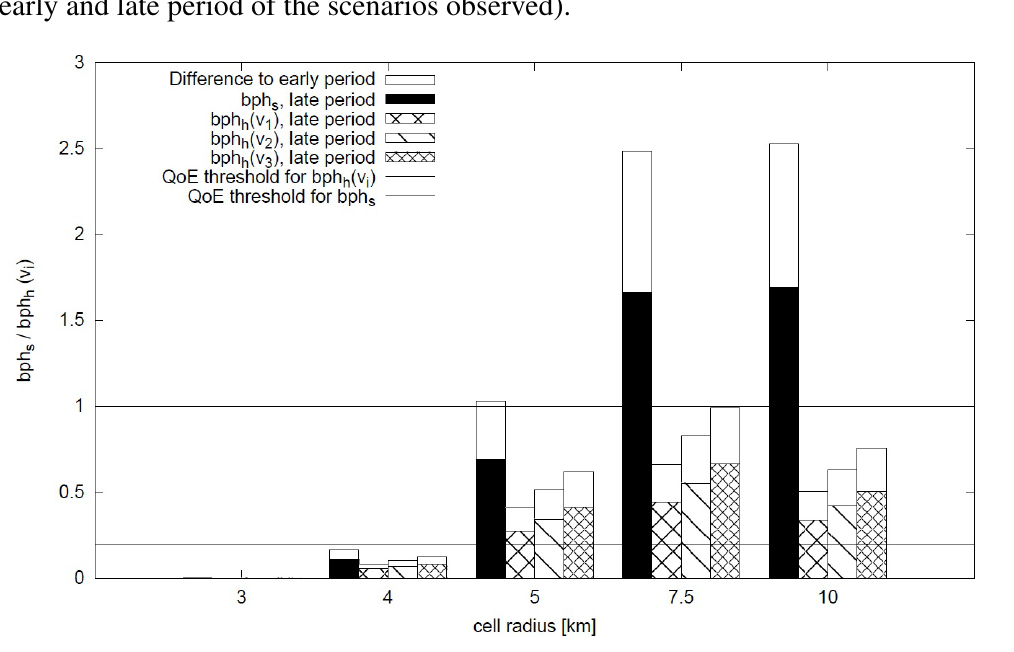
( v ) for different cell sizes and different speeds of vehicles (both for Figure 6. bph and bph s h i the early and late period of the scenarios